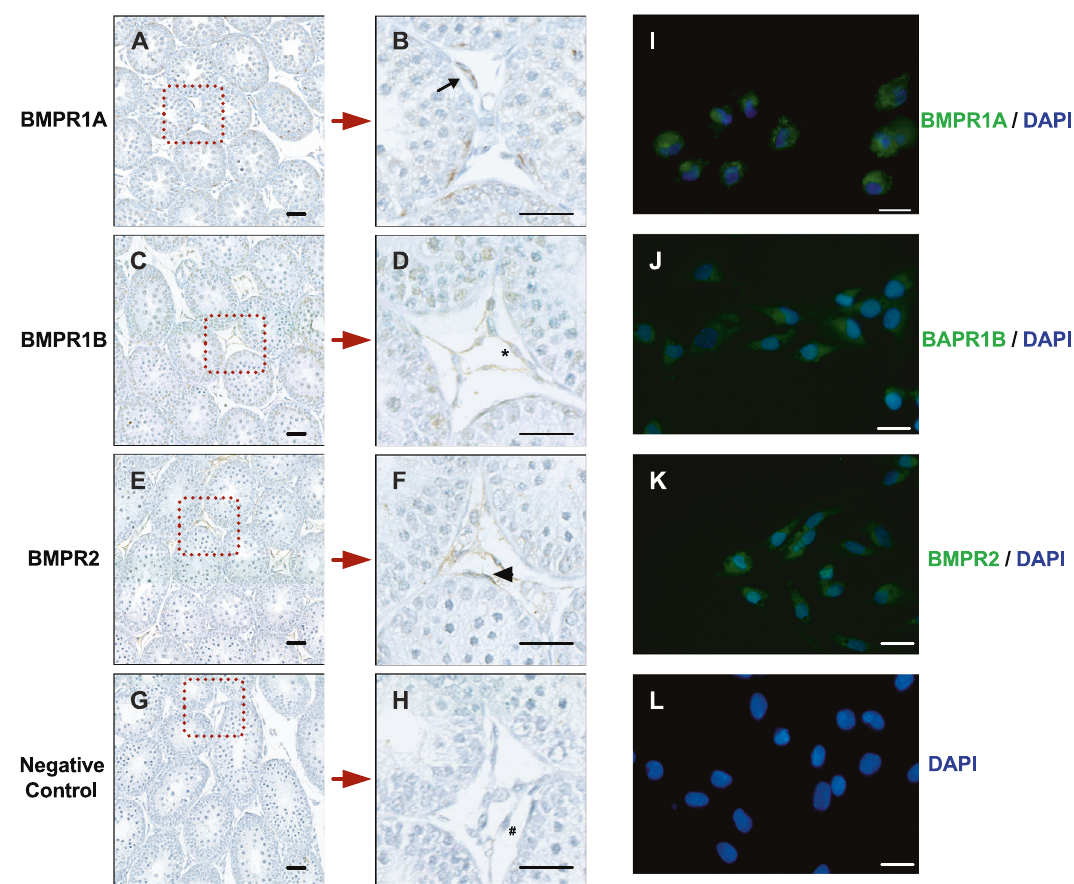
Fig. 1 Detection of BMP4 receptors in rat testis and progenitor Leydig cells (PLCs). A – F Immunohistochemistry of BMPR1A, BMPR1B, and BMPR2 in cross-sections of 21-day-old rat testis (black arrow: BMPR1A + ; asterisks: BMPR1B + , black arrowhead: BMPR2 + . G , H Negative control (#: Leydig cells). Scale bar = 100 μ m. I – L Immuno fl uorescence of BMPR1A, BMPR1B and BMPRII in PLCs. H Negative control. Scale bar = 20 μ